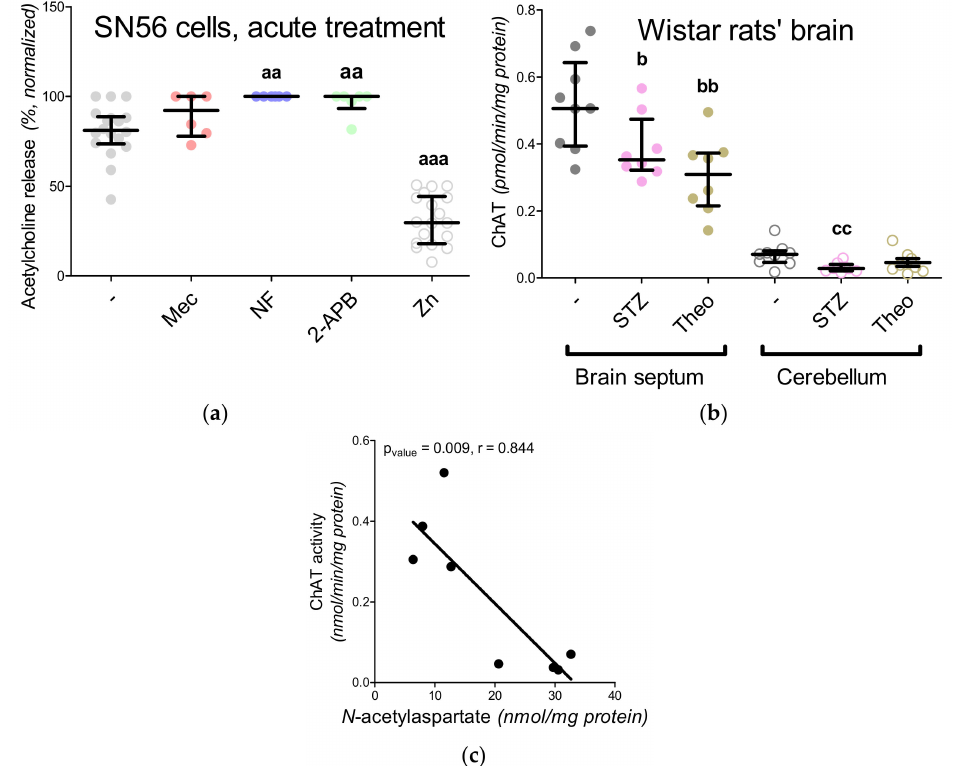
Figure 2. Impact of di ff erent experimental conditions on the expression of cholinergic phenotype in ( a ) SN56 cell line (acute experiments, the release of acetylcholine from SN56 cells, data normalized according to the highest value in each set of experiment, average control acetylcholine release: 50.8 pmol / min / mg protein) and ( b ) Wistar rat brain tissue (2 weeks challenge, choline acetyltransferase activity in male adult Wistar rat brain tissue); ( c ) negative correlation between N -acetylaspartate level and choline acetyltransferase activity (data calculated from Figure 2B and N -acetylaspartate level). Data are median (25th–75th percentile) from 6 to 18 experiments. For in vitro studies, significantly di ff erent from SN56 control ( aa — p < 0.01, aaa — p < 0.001) or Sham control brain septum ( b p < 0.05, bb p < 0.01) or Sham control cerebellum ( cc — p < 0.01). Abbreviations: 2-APB—0.050 mM 2-aminoethoxydiphenyl borate; ChAT—choline acetyltransferase;